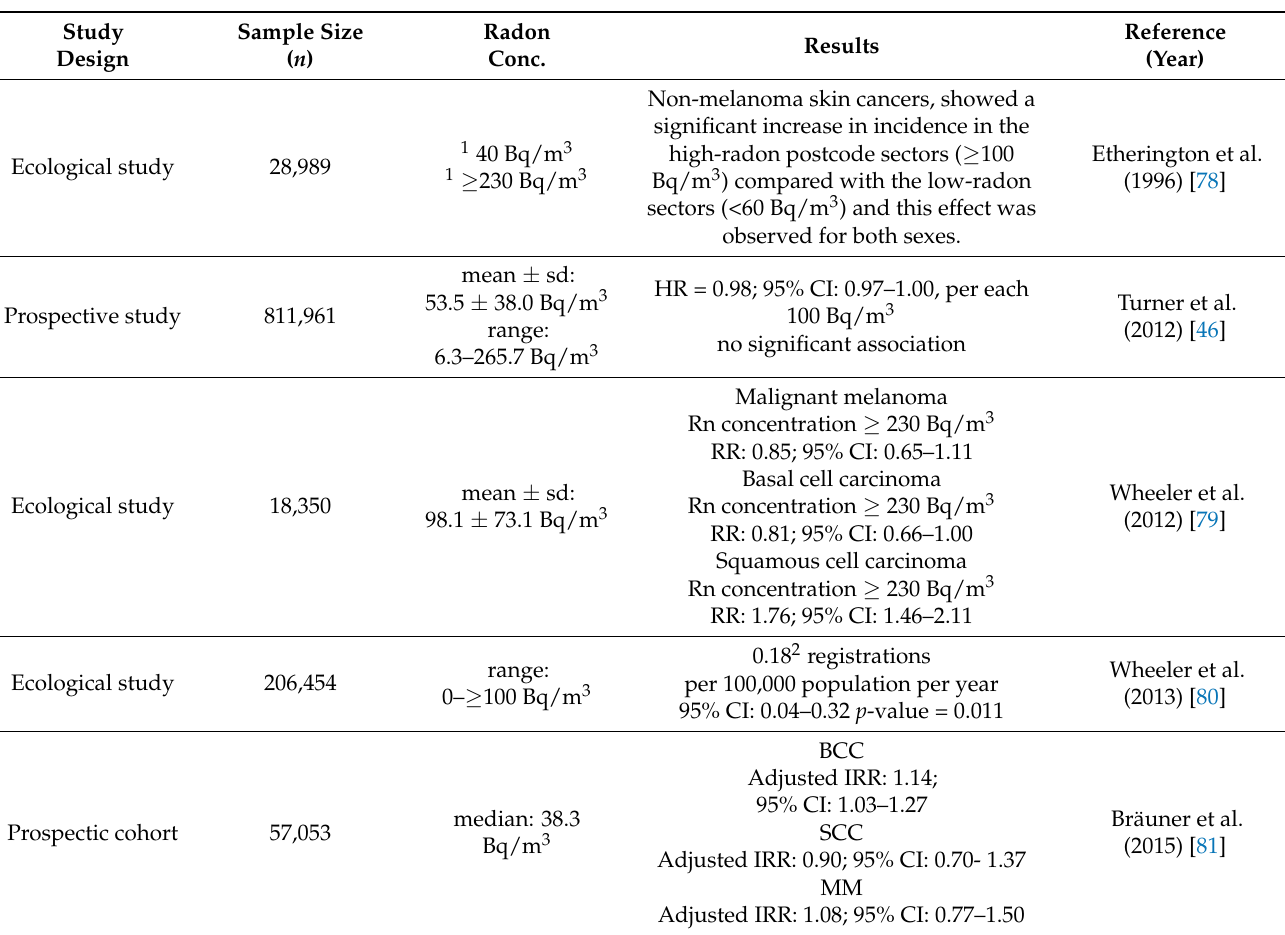
Table 3. Skin cancer: General